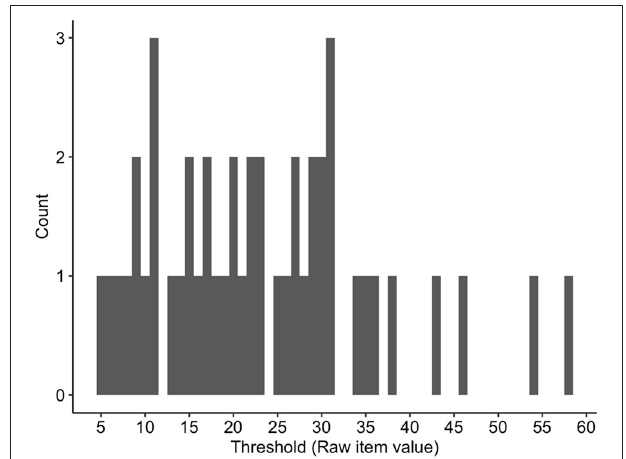
FIGURE 1 | Distribution of individual food craving (FC) thresholds for the whole sample.